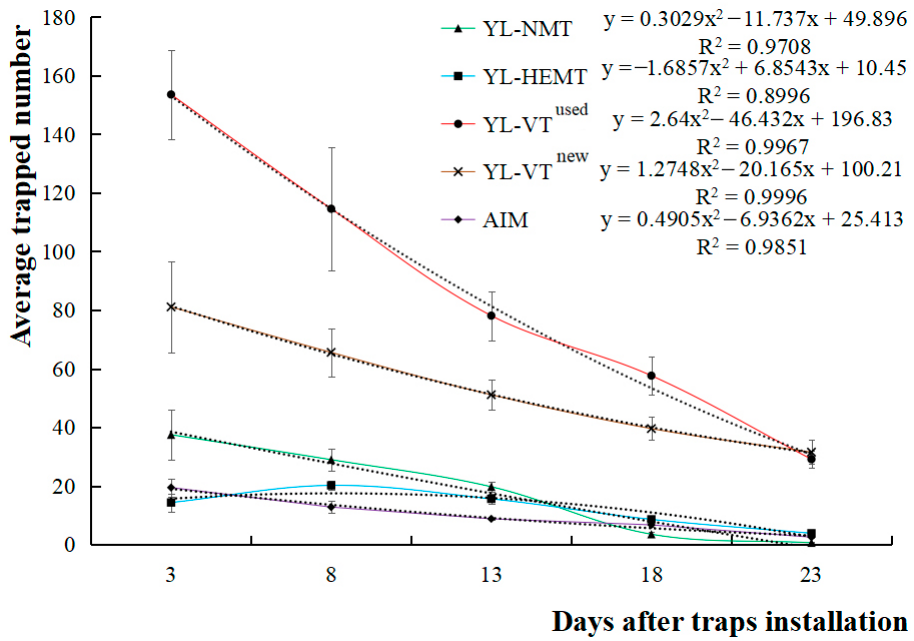
Figure 5. Curve of the number of S. litura trapped by pheromone core in five kinds of traps with time. Average trapped number of S. litura by each trap every 5 days, from 11 September to 5 October in 2020, were used for half-life fitting curve calculation. YL-VT used traps are YL-VT traps that had been used from 5 August to 8 September, and the lure core was replaced for subsequent reuse in the experiment of Date Range 3. YL-VT new traps are new YL-VT traps equipped with new pheromone lure cores. All data are mean ± SE.